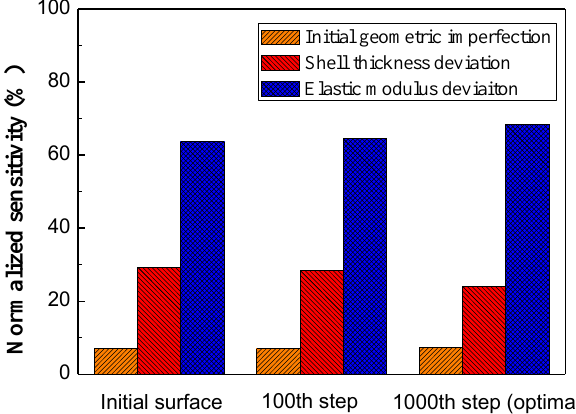
Figure 17. Normalized sensitivity of uncertainty factors of Model 2.